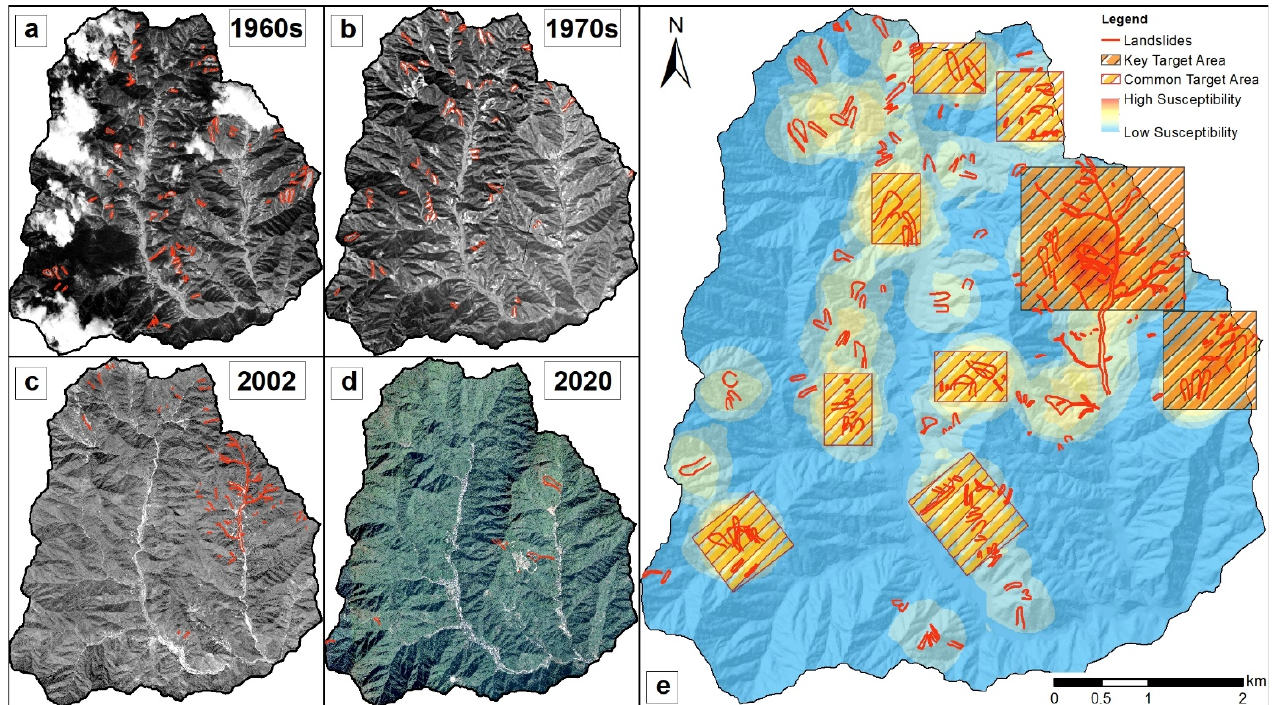
Figure 4. Interpretation results of multitemporal ORS: ( a ) 1960s, ( b ) 1970s, ( c ) 2002, and ( d ) 2020. ( e ) Landslide susceptibility direct mapping by multitemporal ORS interpretation.